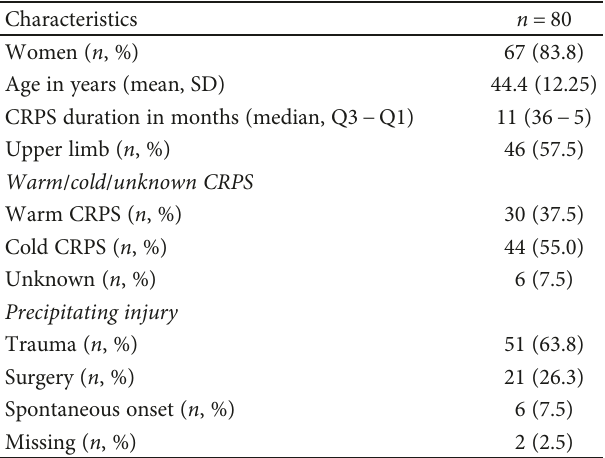
Table 1: Characteristics of the CRPS patients.